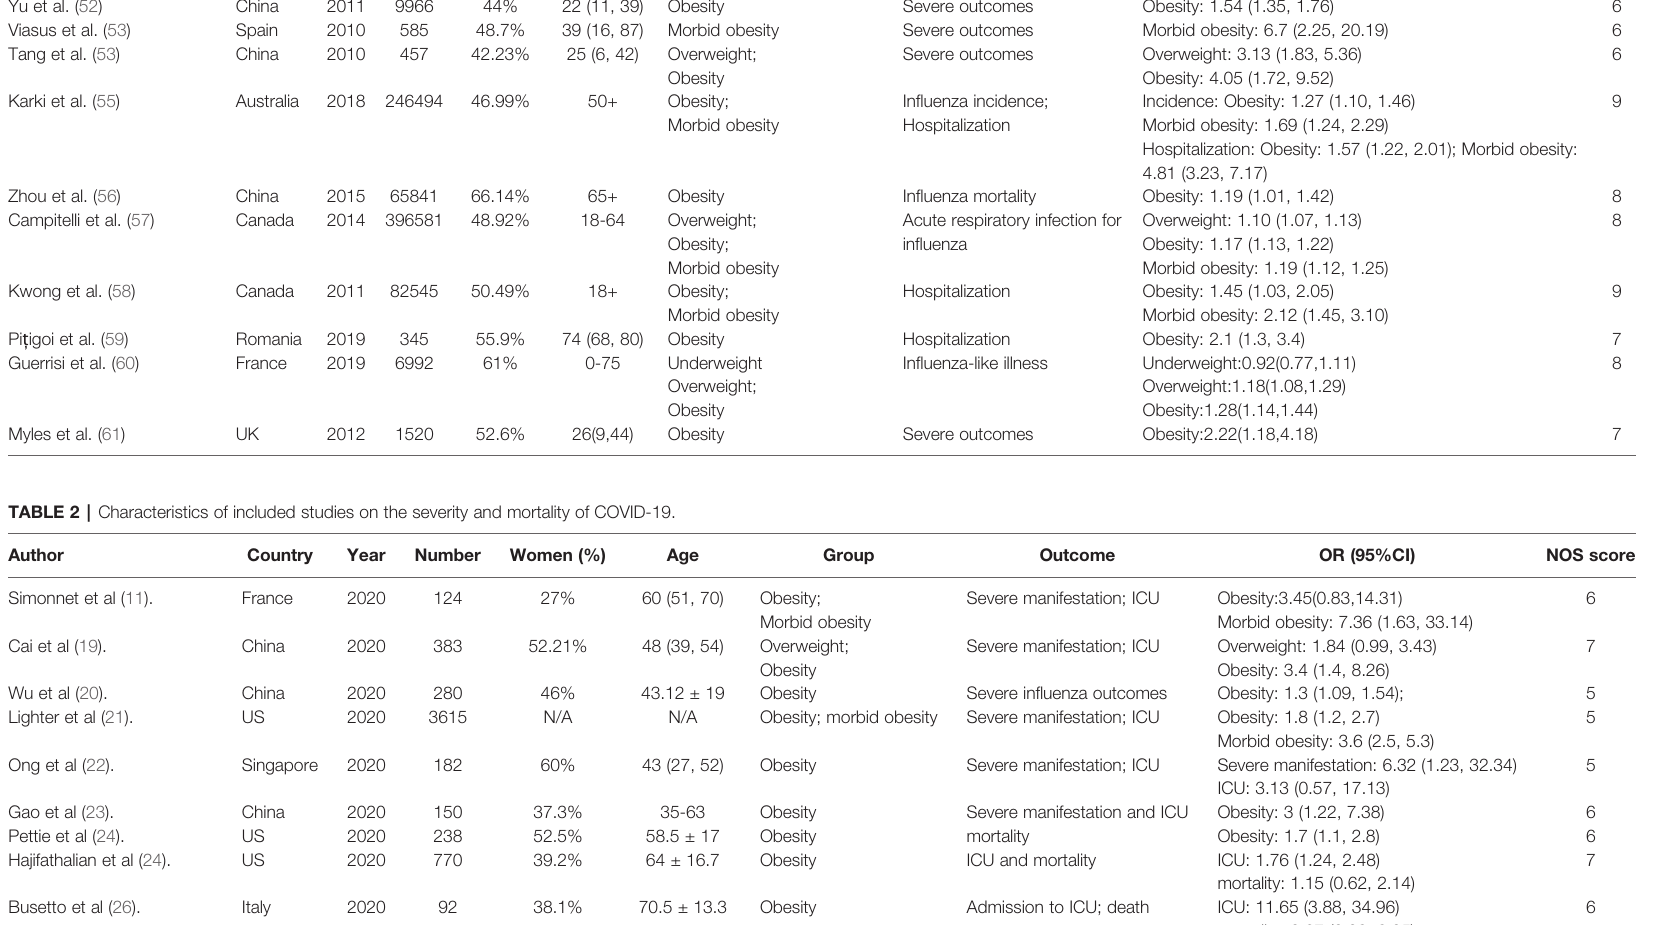
Ong et al (22). Gao et al